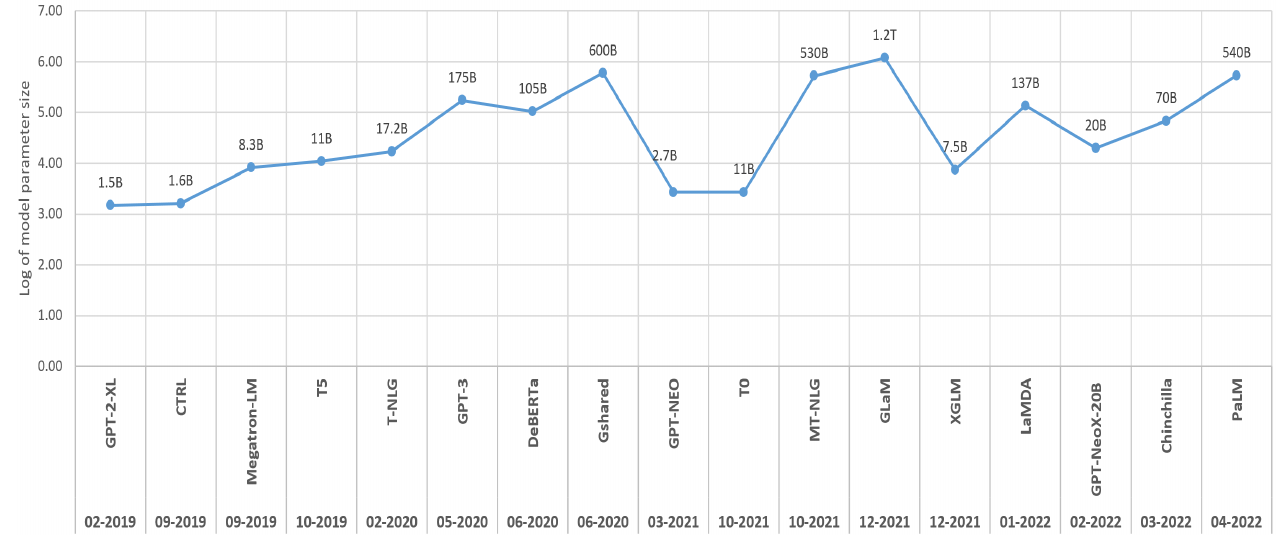
Figure 3. PLMs vs trained parameters (log